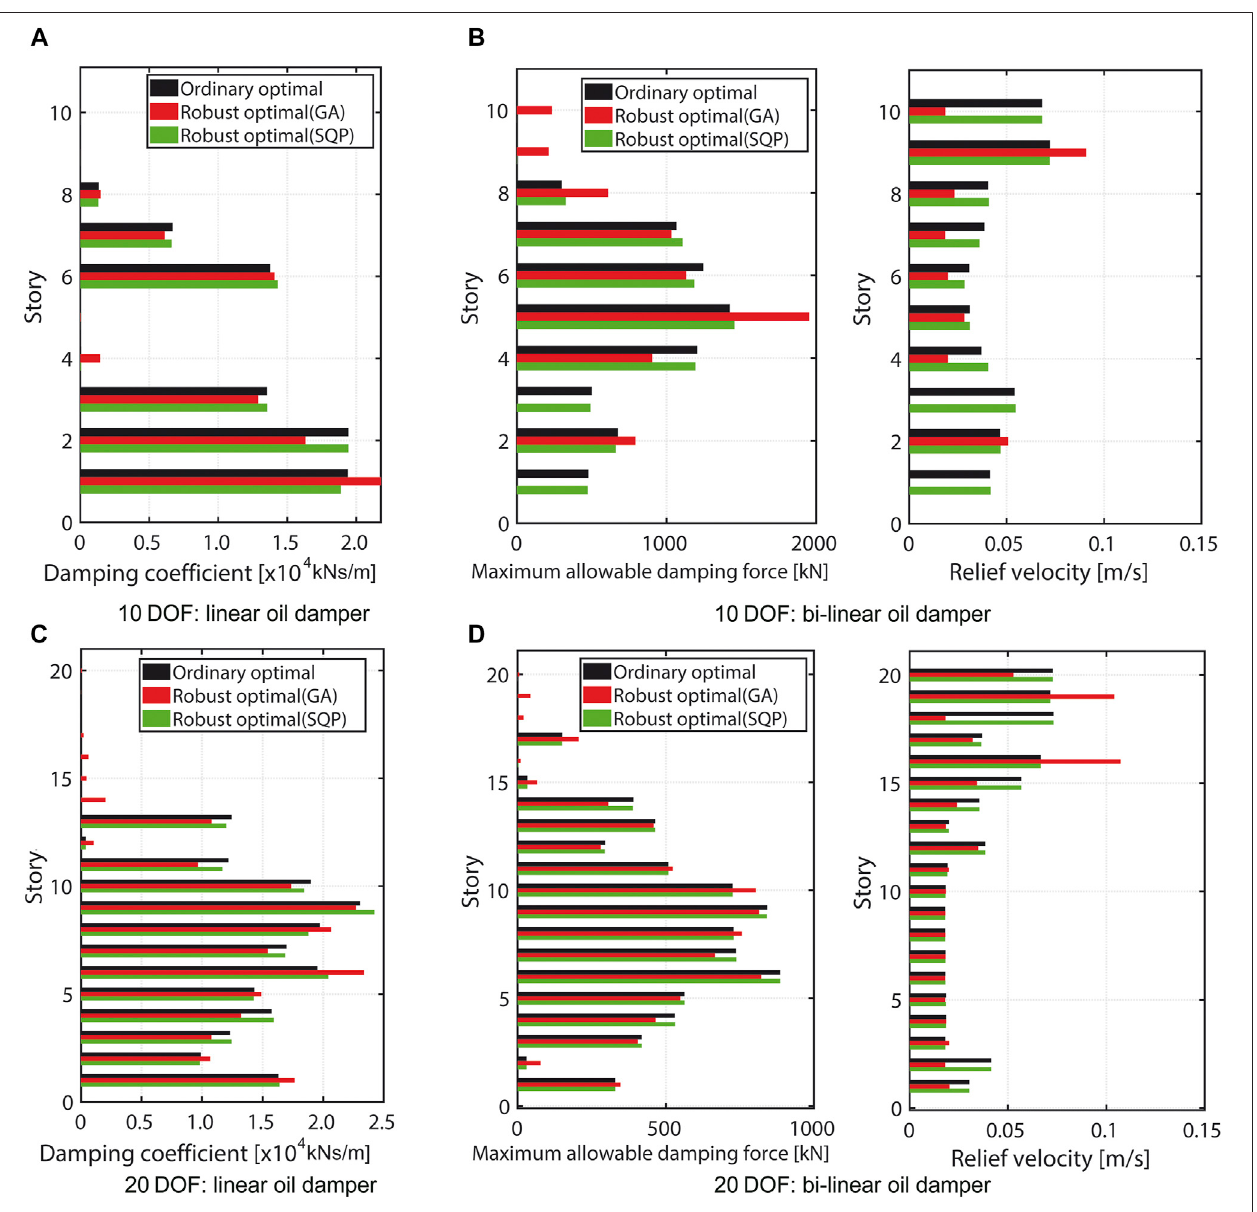
FIGURE 11 | Ordinary optimal damper distribution and robust optimal damper distribution for 10 and 20-story buildings (Damping coef fi cient for linear oil damper, Maximum allowable damping force and relief velocity for bi-linear oil damper).